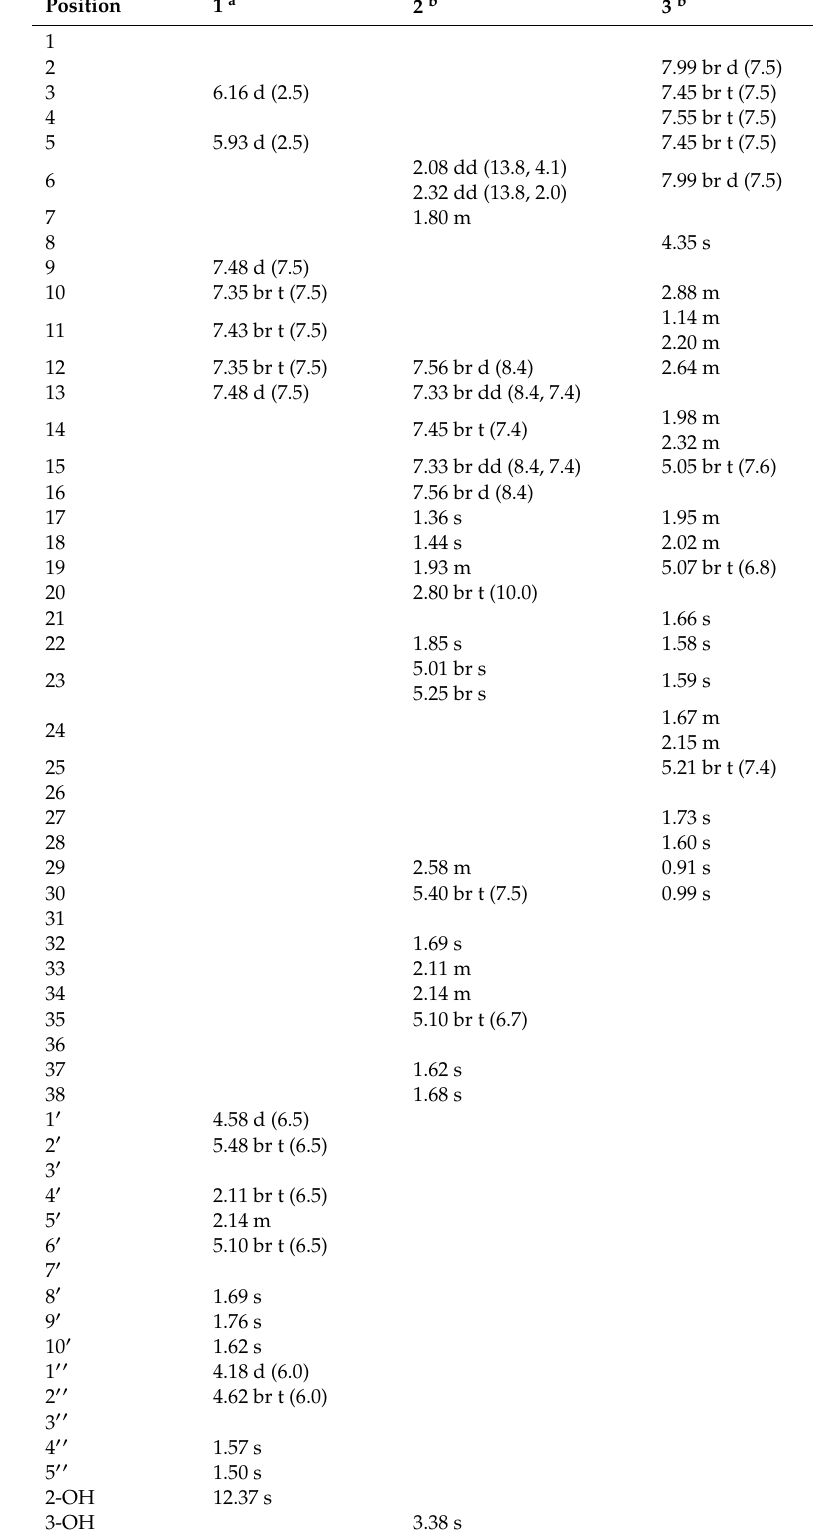
Table 2. 1 H-NMR data for Compounds 1 – 3 ( δ in ppm, J in